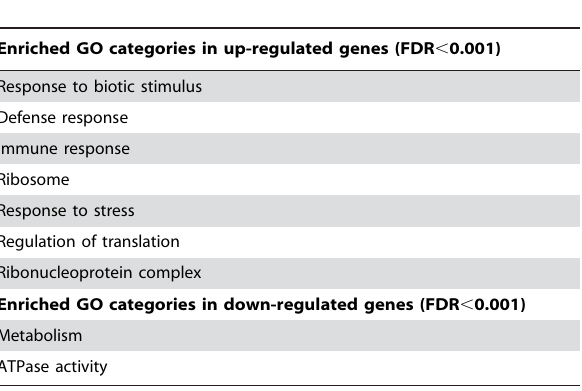
Table 1. GO categories over-represented in the differentially expressed genes from the PbA model of ALI